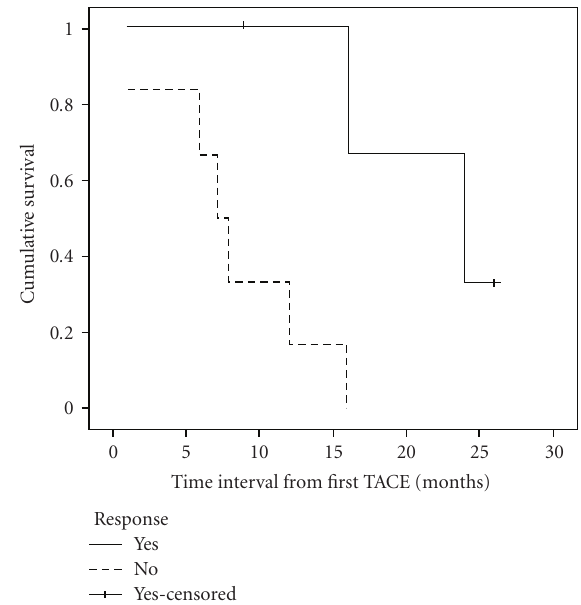
Figure 4: Kaplan-Meier survival curve of responders and non- responders to TACE